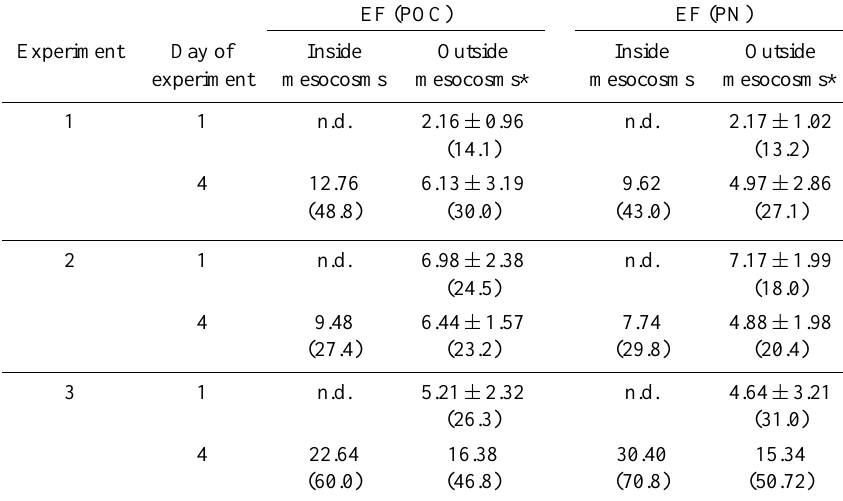
Table 3. Enrichment factors (EF) of particulate organic carbon (POC) and particulate nitrogen (PN) inside and outside the mesocosms. Outside the mesocosms, samples were taken on the first and the last day of each experiment; inside the mesocosms, samples were only taken on the last day of each experiment. Values in parentheses indicate contribution of the particulate matter to the total organic matter pool